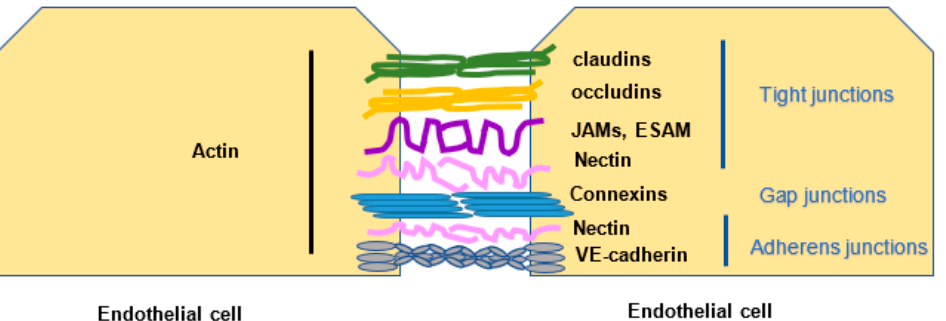
Figure 1. Endothelial cell junctions. Endothelial cells linked one to the other by different types of junctions form a barrier. Tight junctions: claudins, occludins, junction adhesion molecule (JAMs), endothelial cell-selective adhesion molecule (ESAM), and nectin. Gap junctions: connexins. Adherens junctions: nectin, VE-cadherin.